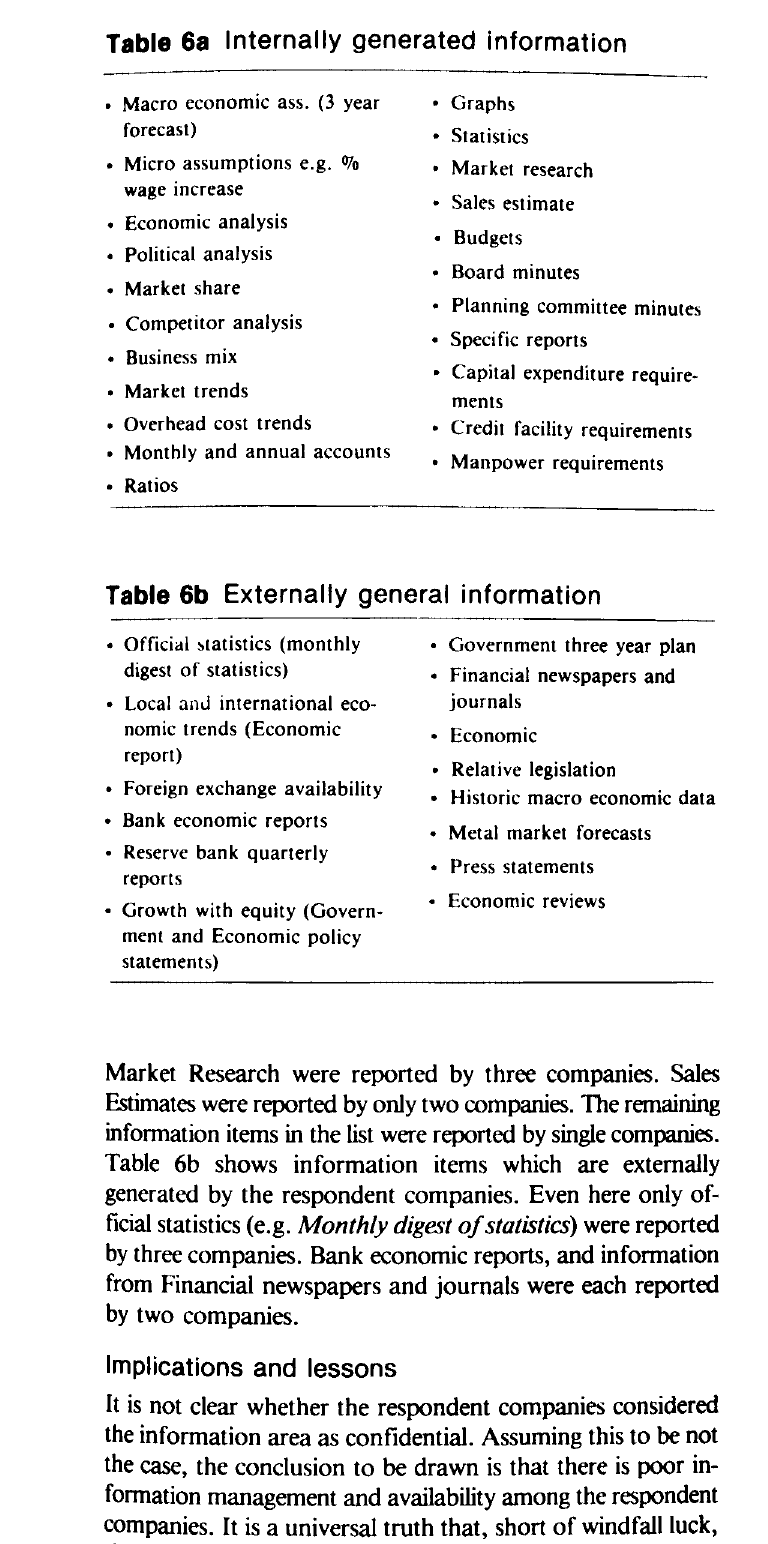
Table 6a Internally generated